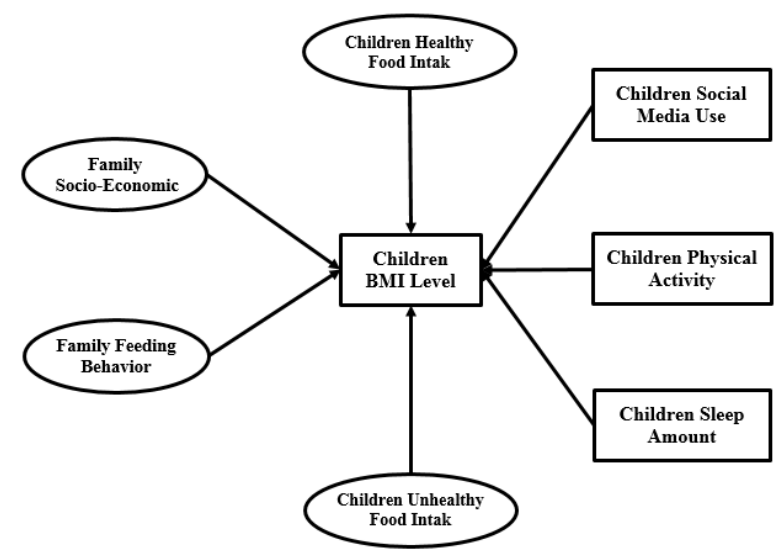
Figure 5. SEM research model.